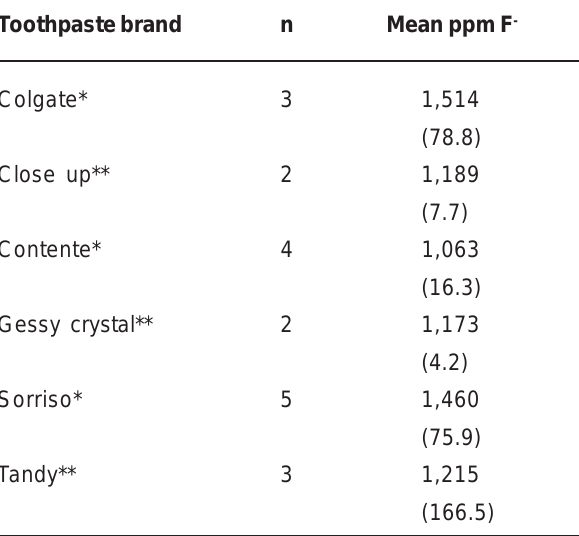
TABLE 1 - Mean Fluoride (±SD) concentration in toothpastes used by children in Penedo,